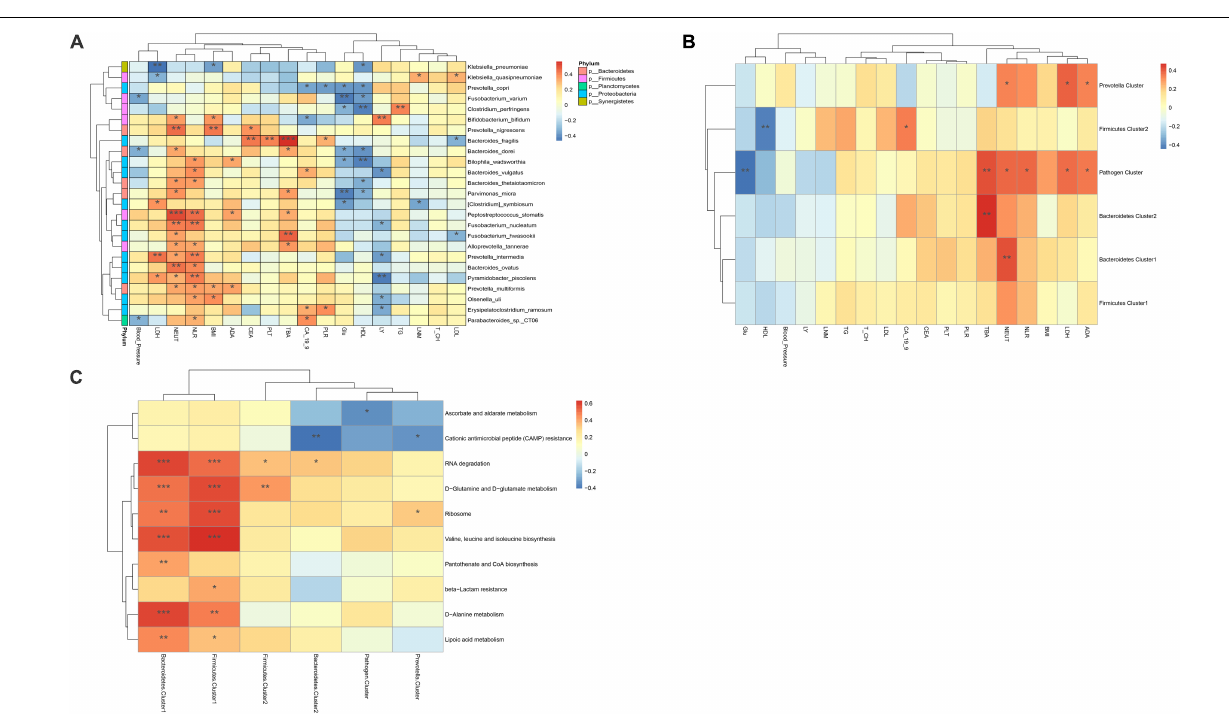
resistance genes (e.g., mdtP, mdtO, GadW, GadX, AcrA), 3 (cid:48) - aminoglycoside [AAC(3)-IIa, AAC(3)-IIc, aadA5], 2 quinolone (EmrR, emrB), 1 Sul2, TetQ, and ampC. In tissue, a total of